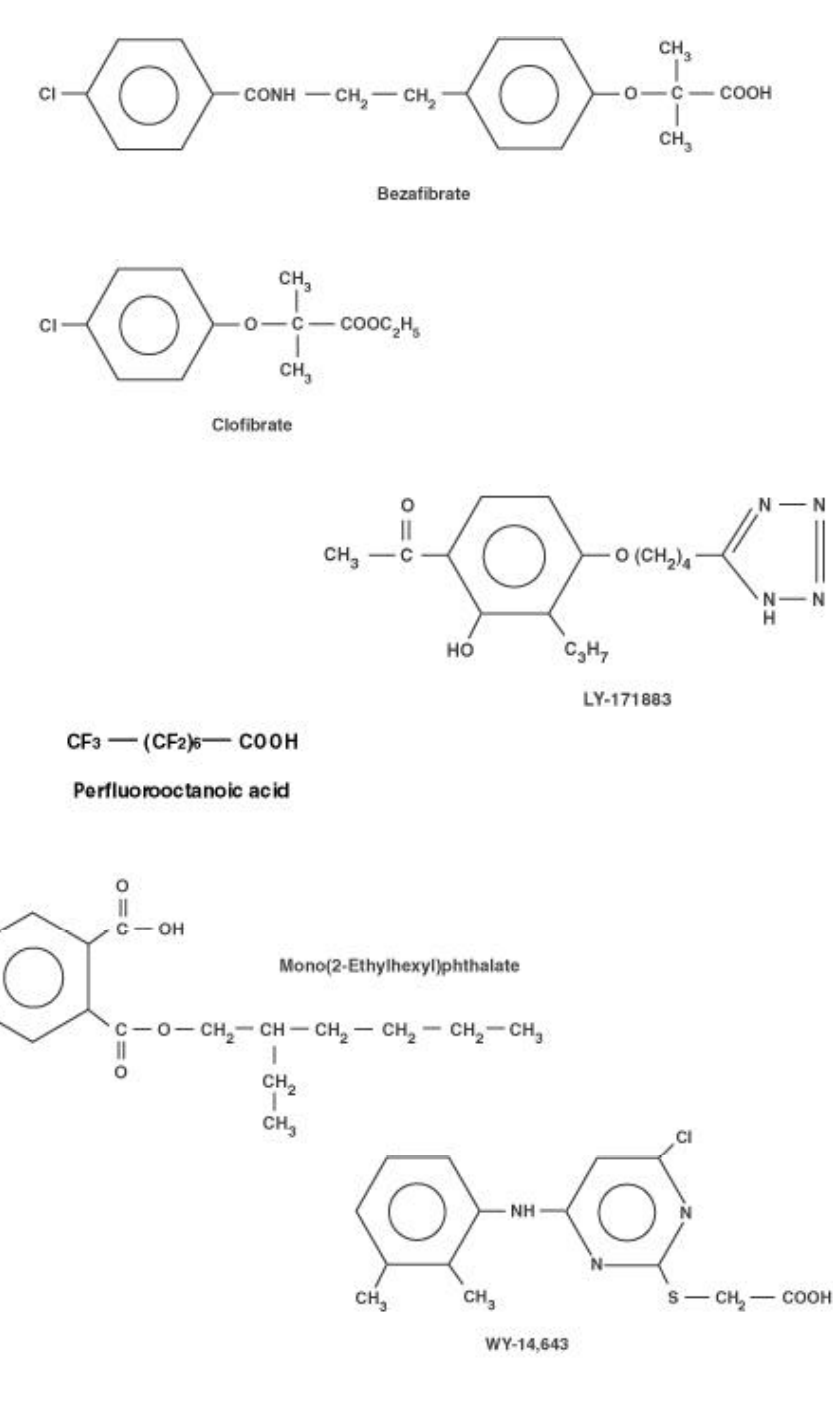
FIGURE 2. Chemical structures of representative PPAR